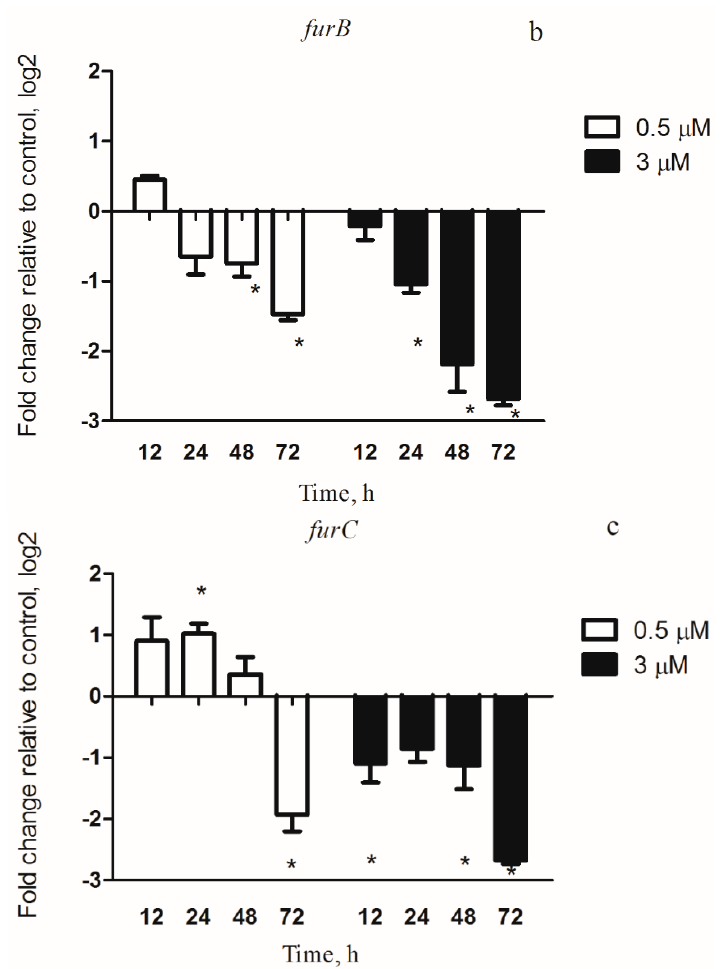
Figure 3. Relative expression levels of the iron metabolism genes ( furA , furB , furC ) in M. aeruginosa PCC 7806 under copper stress. ( a ) the furA gene; ( b ) the furB gene; and ( c ) the furC gene. The 0.5 µM: M. aeruginosa cells were incubated with 0.5 µM copper for 12, 24, 48, or 72 h. The 3 µM: M. aeruginosa cells were incubated with 3 µM copper for 12, 24, 48, or 72 h. Results are the mean ± SD from 3 separate determinations. * represents significance at p < 0.05 between the copper-treated groups and the control group.